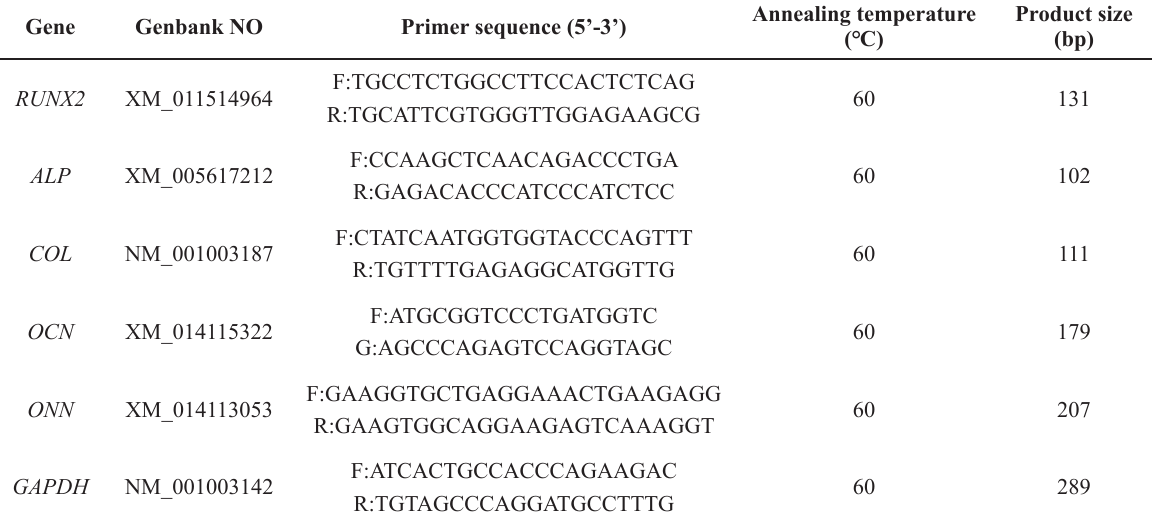
Primers used in the reverse transcription-quantitative polymerase chain reaction analysis.